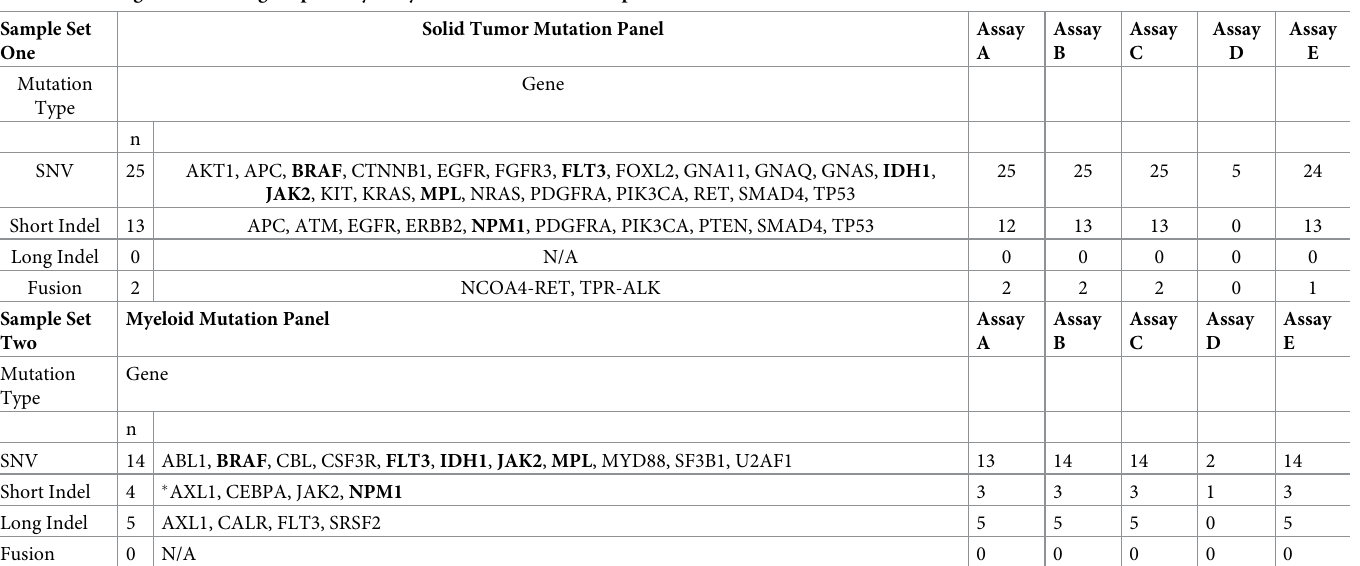
Table 2. Coverage of reference gene panel by assay A to E for reference samples. Sample Set